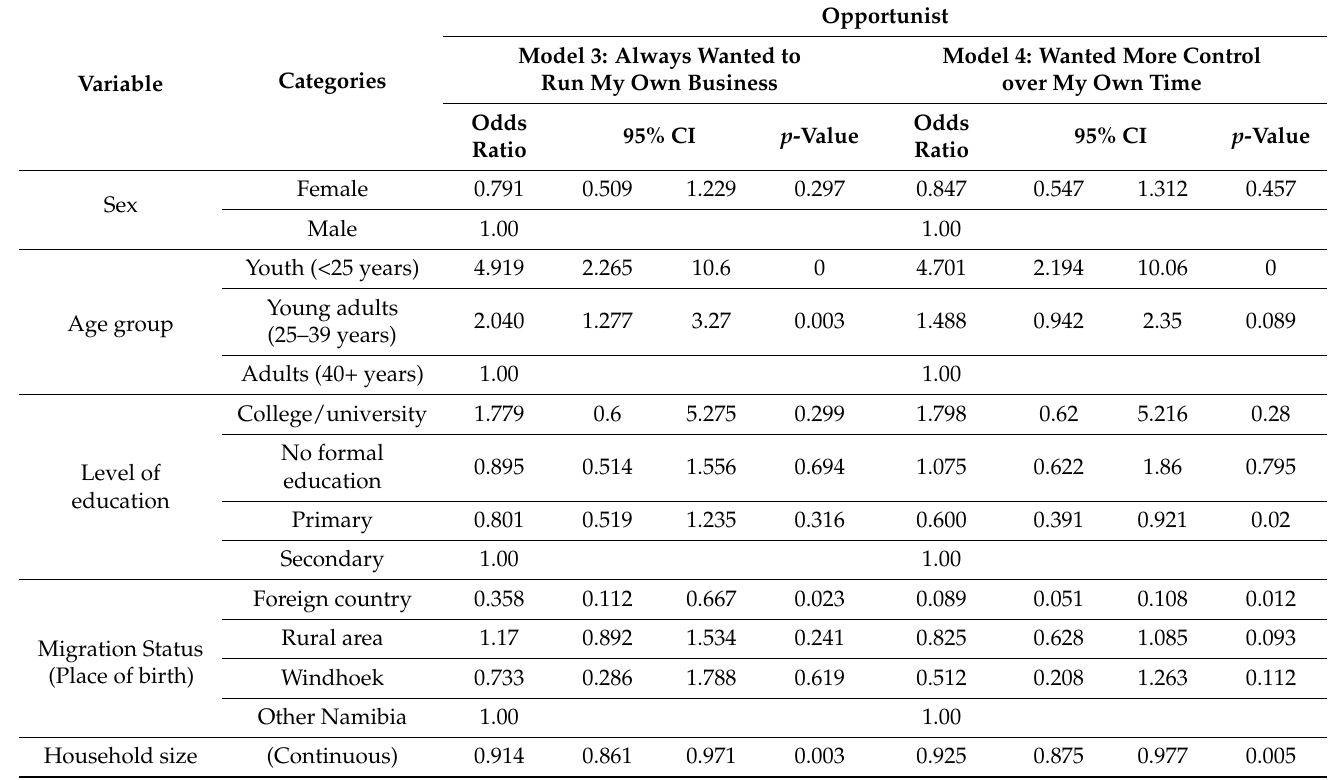
Table 13. Characteristics of